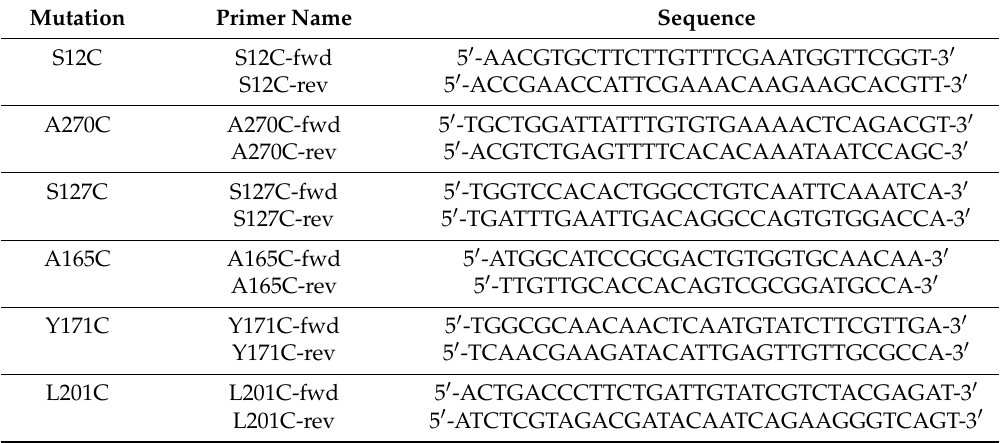
Table 2. The sequences of the